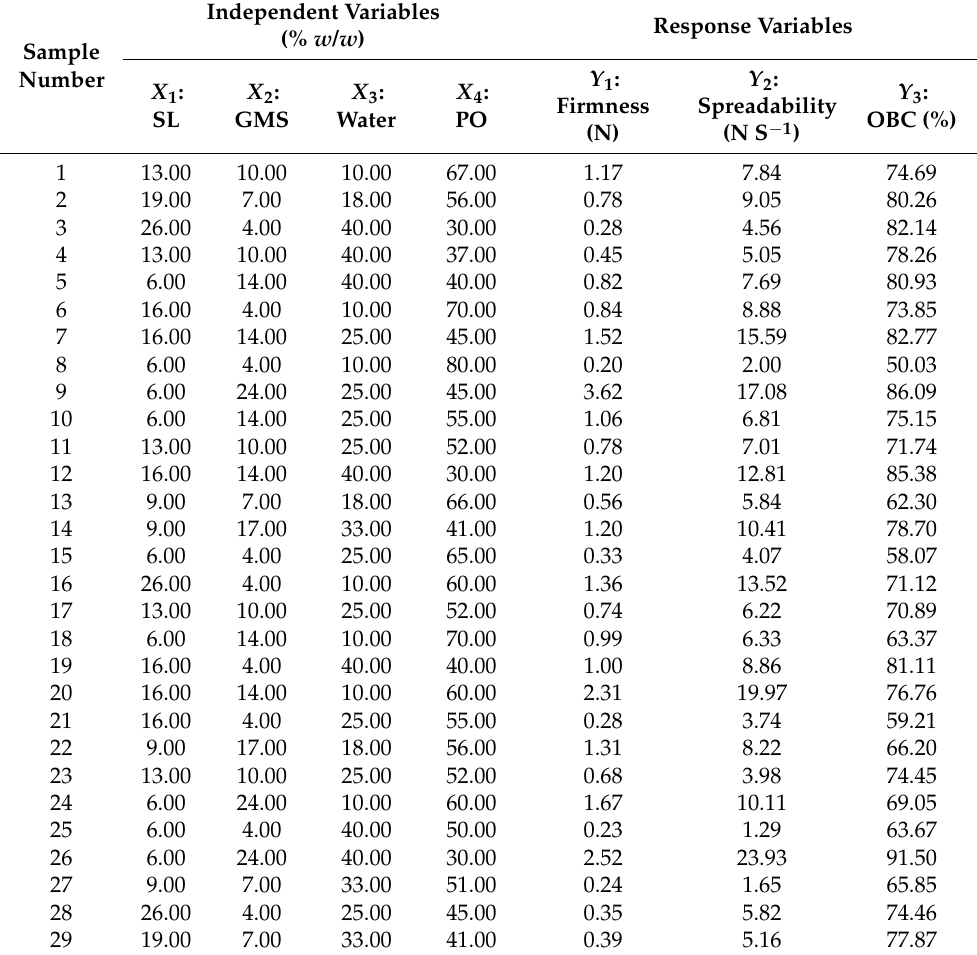
Table 1. Experimentally measured response variables for organogels formulated with different proportions of soy lecithin (SL), glyceryl monostearate (GMS), water, and palm olein (PO).